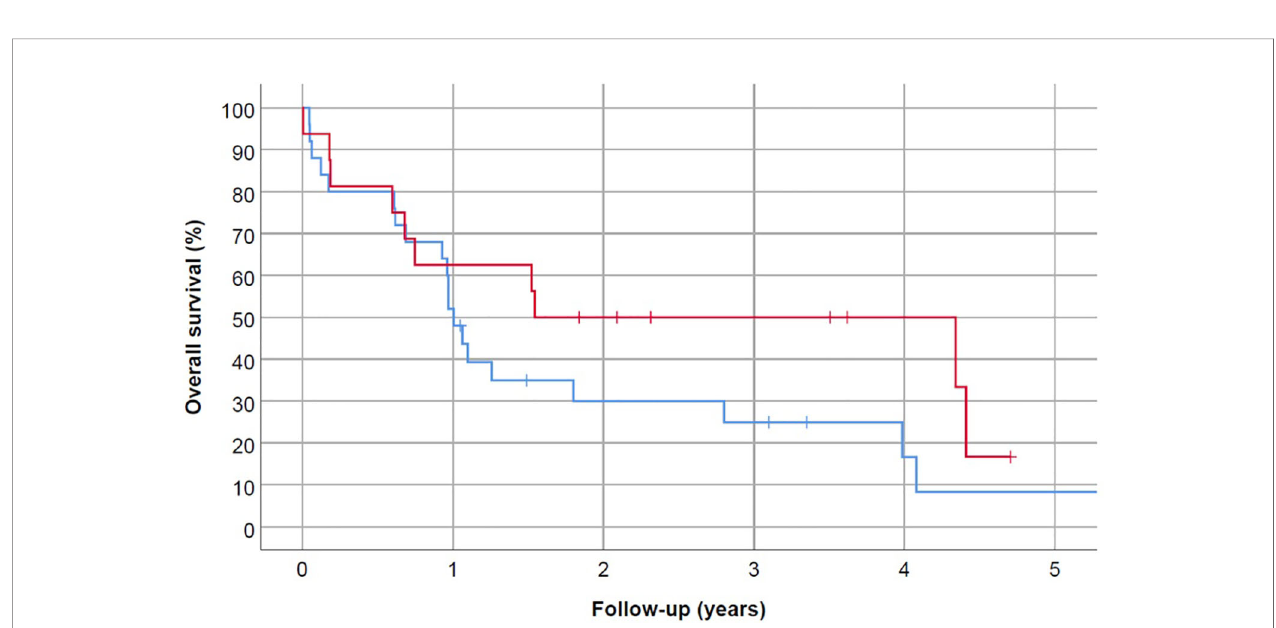
FIGURE 3 | Overall survival did not correlate with ASPH status (p=0.169). Blue line represents ASPH-negative AML patients and red line is ASPH-positive AML patients. Patients were censored at the time of death, loss to follow-up, or HSCT.